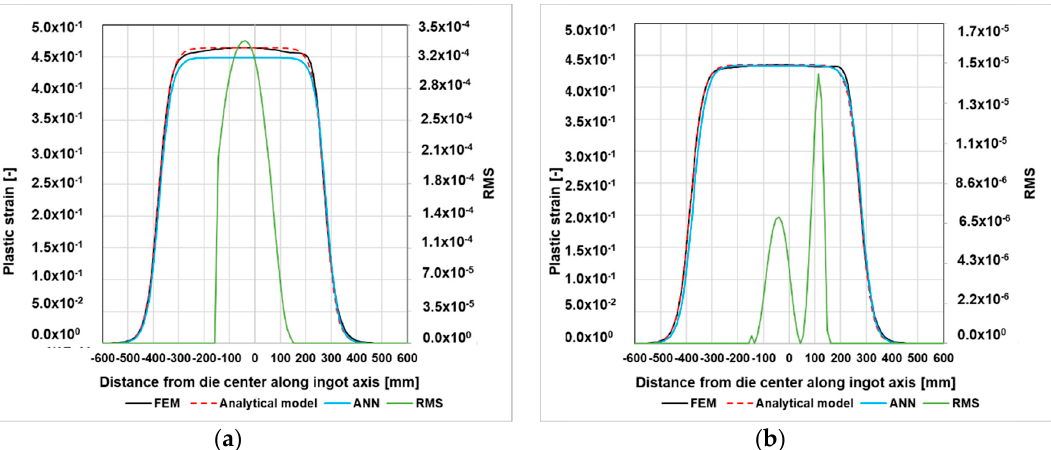
Figure 13. Total equivalent plastic strain as a function of length for Sb 0 = 750 mm, reduction of 25% for first stroke at ( a ) 800 °C, ( b ) 1200 °C.